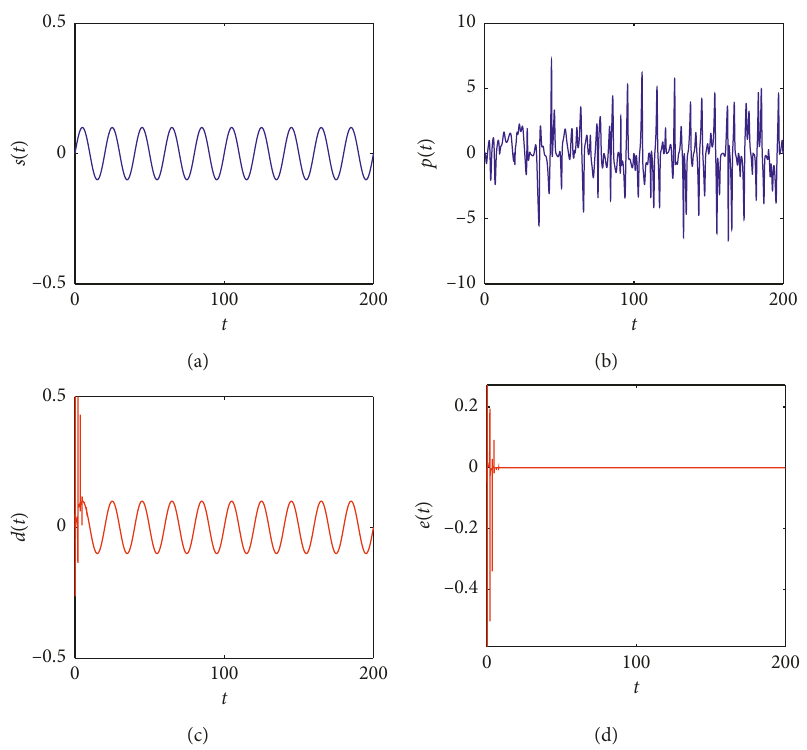
Figure 18: (a) Original signal s ( t ) , (b) transmitted signal p ( t ) , (c) recovered signal d ( t ) , and (d) error e ( t ) � s ( t ) − d ( t ) .